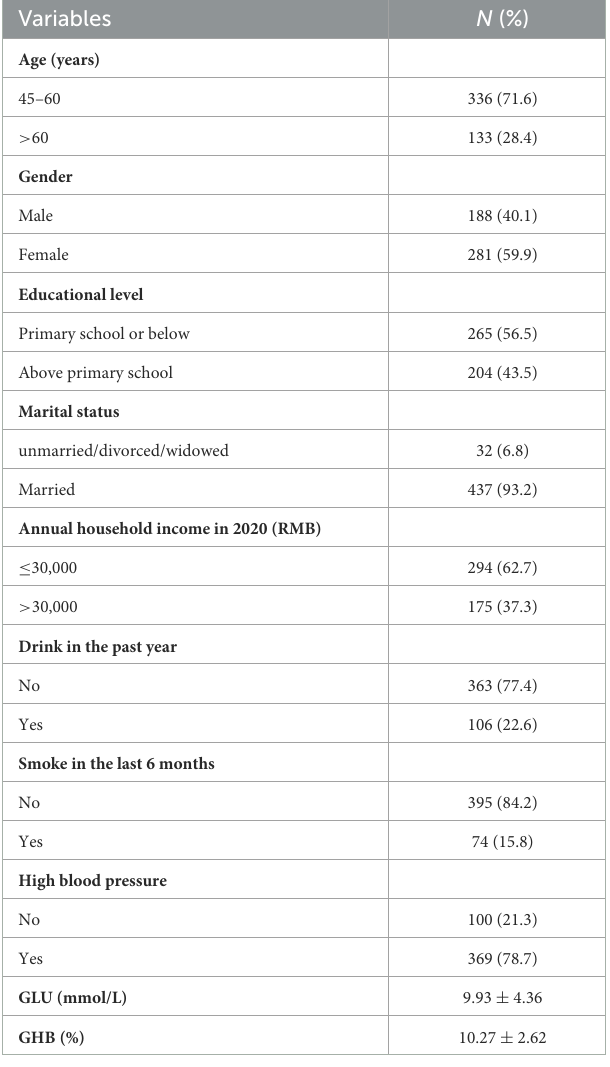
TABLE 1 Demographic characteristics of participants ( n =